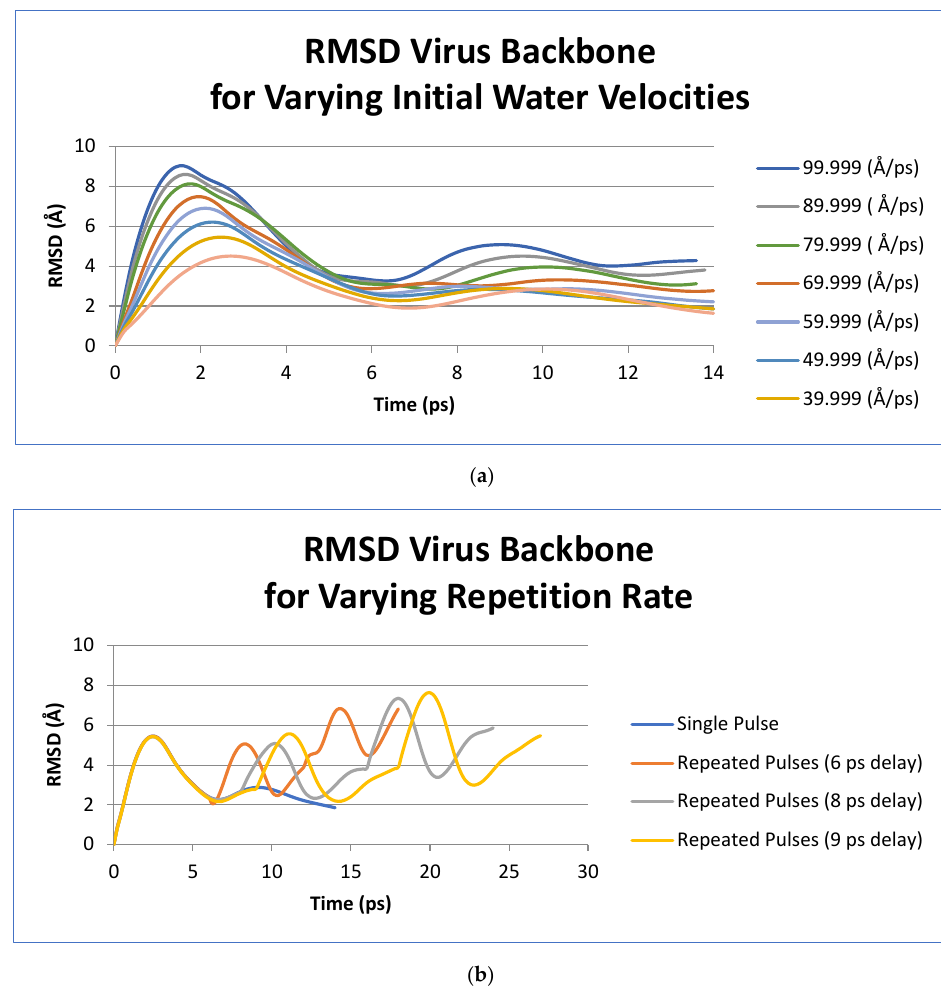
Figure 1. Response of virus structure to shockwave pulses ( a ) RMSD curves exhibiting the oscillatory response of the virus to single shockwave pulses — each curve represents the time evolution of the deformation of the virus structure for a given initial velocity value assigned to water molecules in the water slice to initialize the shockwave. ( b ) RMSD curves showing response of the virus to repeated shockwaves pulses compared to a single shockwave pulse — a varying delay between pulses leads to variation in the overall amplitude of deformation of the structure.